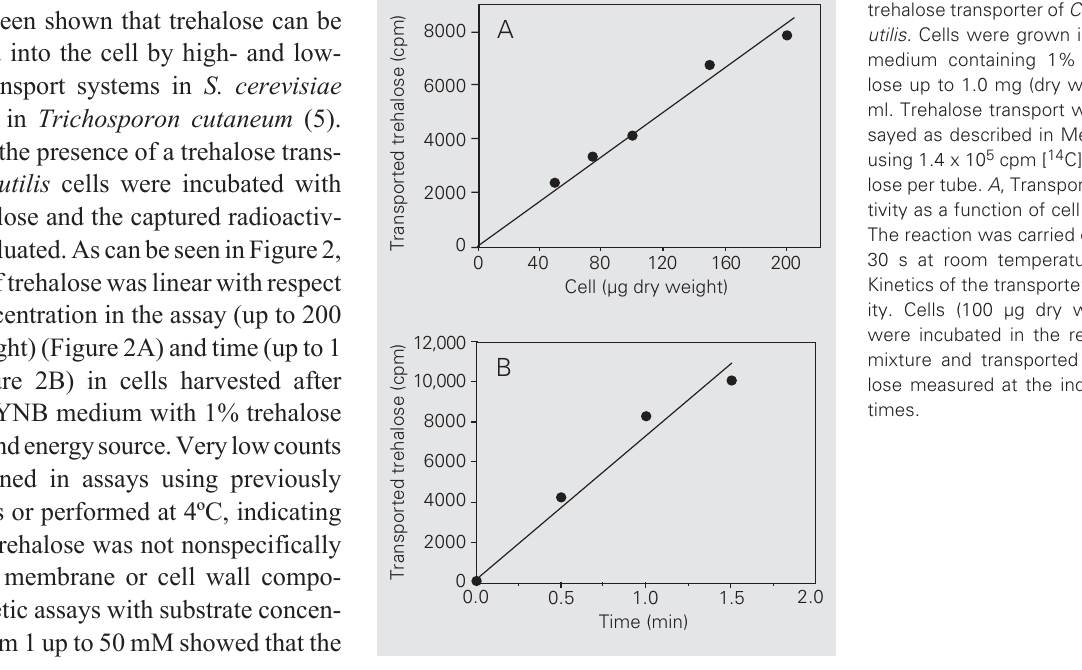
Figure 2. Characterization of the trehalose transporter of Candida utilis . Cells were grown in YNB medium containing 1% treha- lose up to 1.0 mg (dry weight)/ ml. Trehalose transport was as- sayed as described in Methods using 1.4 x 10 5 cpm [ 14 C]-treha- lose per tube. A , Transporter ac- tivity as a function of cell mass. The reaction was carried out for 30 s at room temperature. B , Kinetics of the transporter activ- ity. Cells (100 µg dry weight) were incubated in the reaction mixture and transported treha- lose measured at the indicated